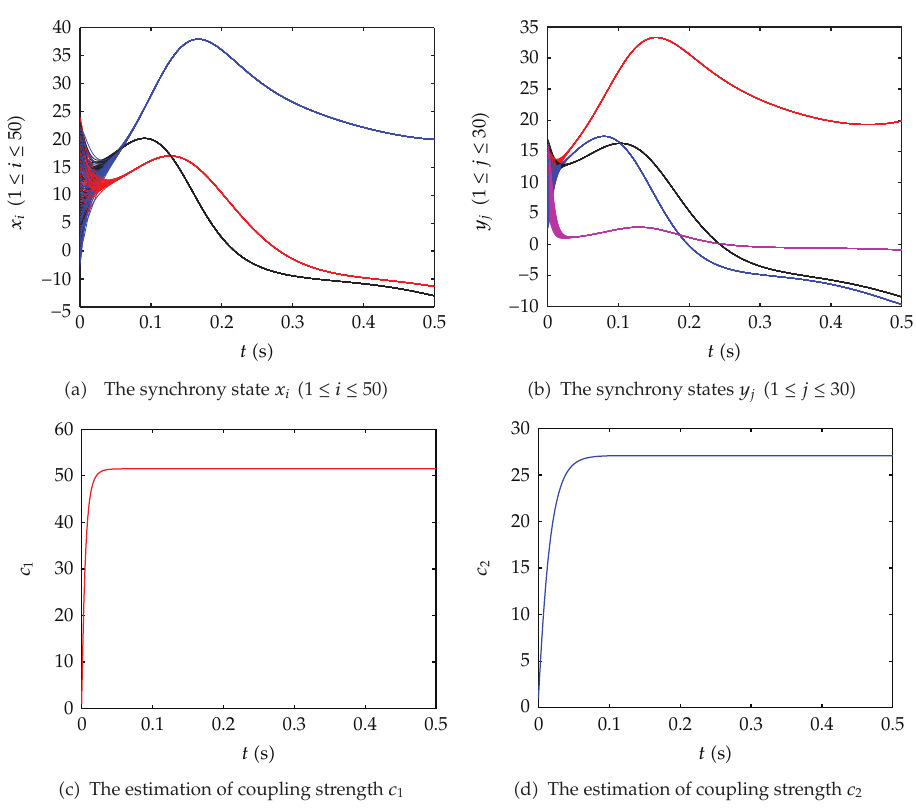
Figure 3: Cluster synchronization of the adaptively coupled network (cid:4) 2.1 (cid:5) with 50 lorenz oscillators in the x -cluster and 30 hyperchaotic L¨u oscillators in the y